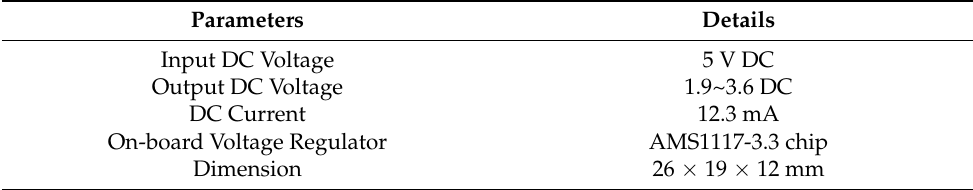
Table 1. Specification of NRF Adapter module.